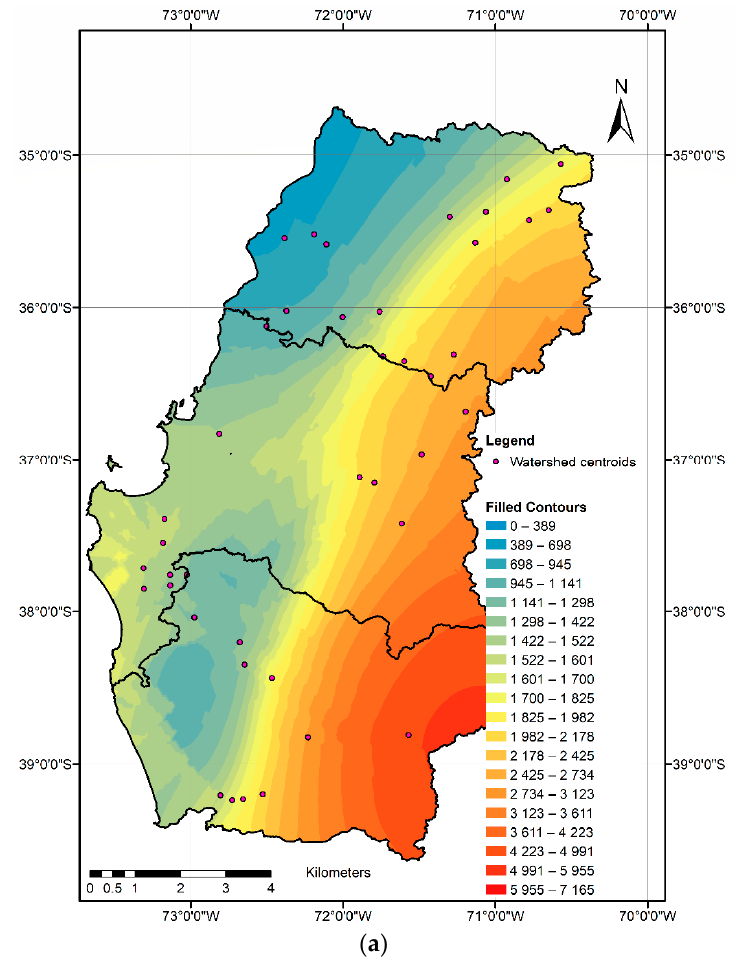
Figure 3. Percent difference in the AAP calculated by isohyets and inverse modeling for each watershed. Made by the